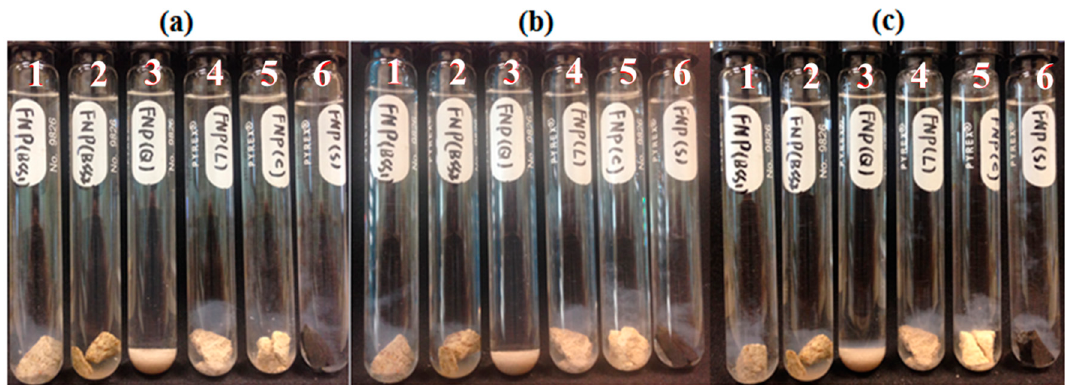
Figure 6. FNP suspensions with reservoir rocks: ( a ), Day 0; ( b ), Day 1; ( c ), Day 3. (1: BBS1; 2: BSS2; 3: quartz; 4: limestone; 5: chalk; 6: shale).